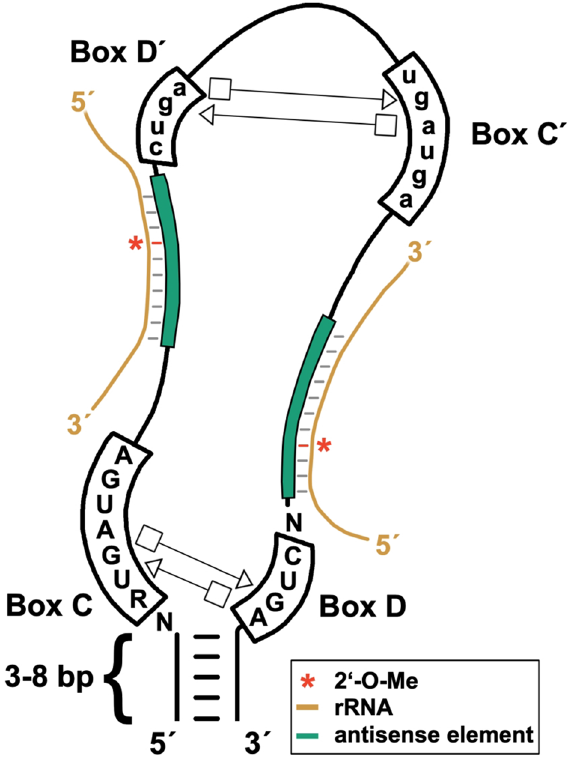
Figure 1. Features of box C/D snoRNAs. Conserved residues of boxes C and D are shown. They interact to form a functionally important k-turn by means of trans Hoogsteen/sugar-edge A•G base pairs, shown in conventional Leontis–Westhof symbols 75 . The guiding sequences (“antisense element”; green) is upstream of the D box with methylation occurring in rRNA at the position pairing to the 5th nucleotide upstream of the D box (indicated with a red asterisk). Base pairing with rRNA (beige) is schematically shown. Boxes C ′ and D ′ are usually less well conserved (indicated by small lettering). The separate antisense sequence upstream of box D ′ , allows guidance to a further methylation